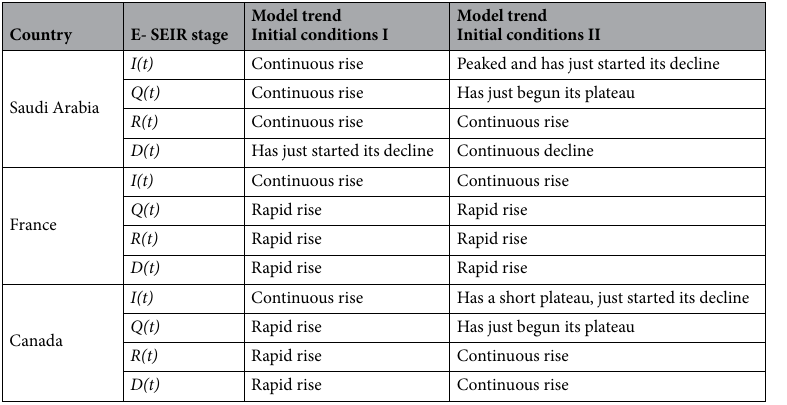
Table 2. E-SEIR model curves trends summary for two initial conditions sets for Saudi Arabia, France, and Canada.